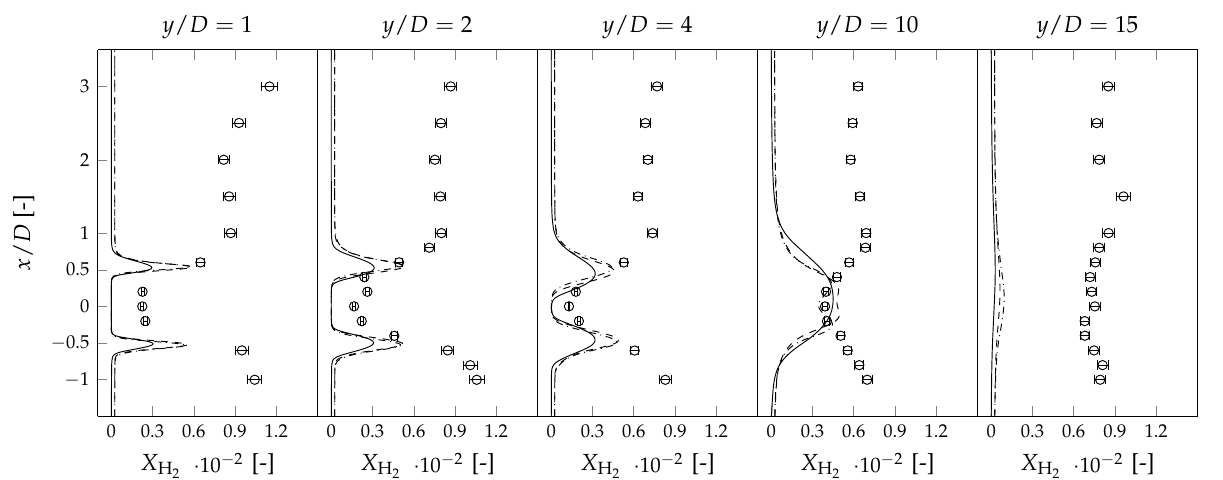
Figure 16. Mean molar fraction of H 2 O at various stream-wise locations. FGM-NAC (——), FGM-NA (– – –), FGM-A (–·–·–), Raman measurement results ( ◦ ) [2].